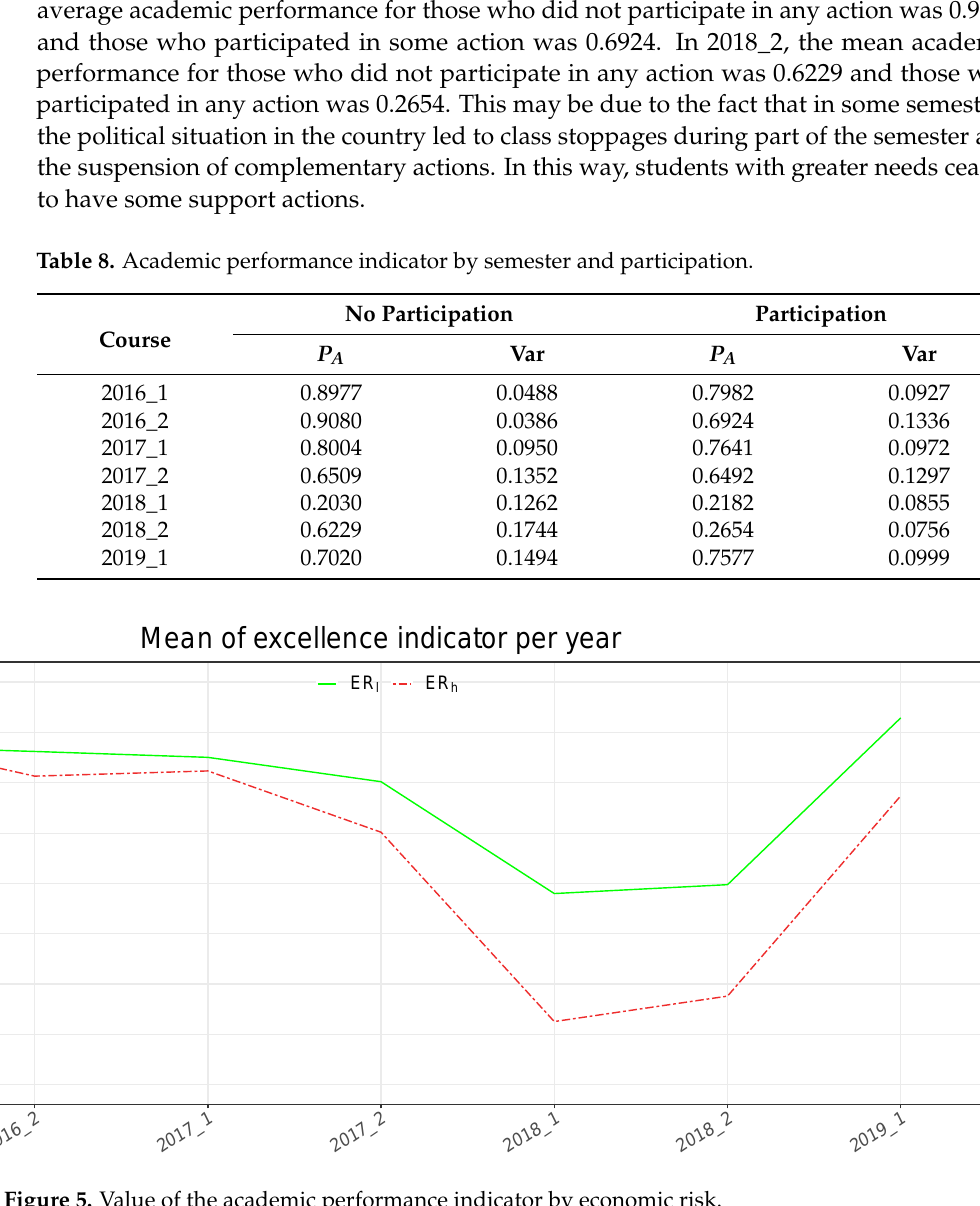
Table 7. Academic performance indicator values by semester per economic condition.